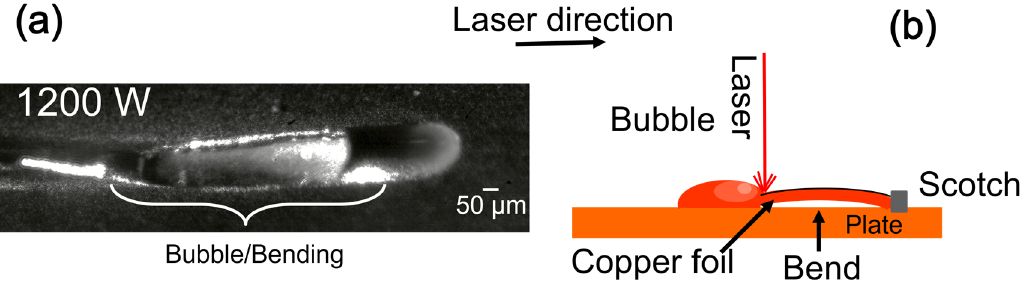
Figure 8. ( a ) Topography recording frame of the fusion using 1200 W during forming a vapor bubble. ( b ) Schematic representation of the cross-section fusion on copper foils.